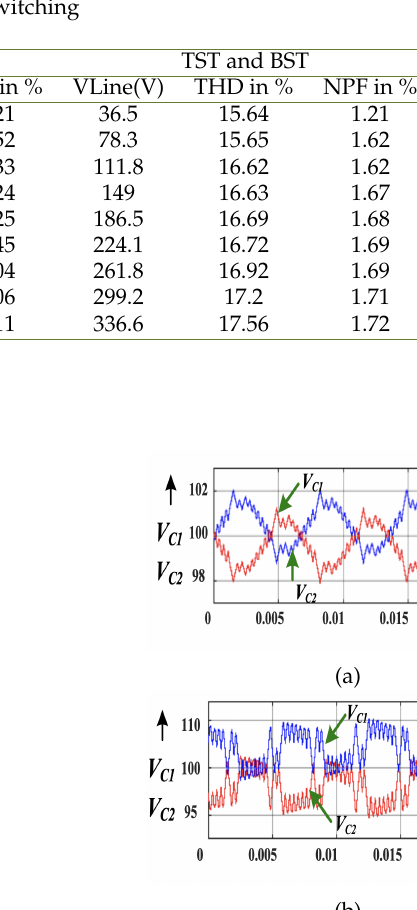
Table 4. Inverter performance at different modulation index values for FST and proposed combination of TST and BST